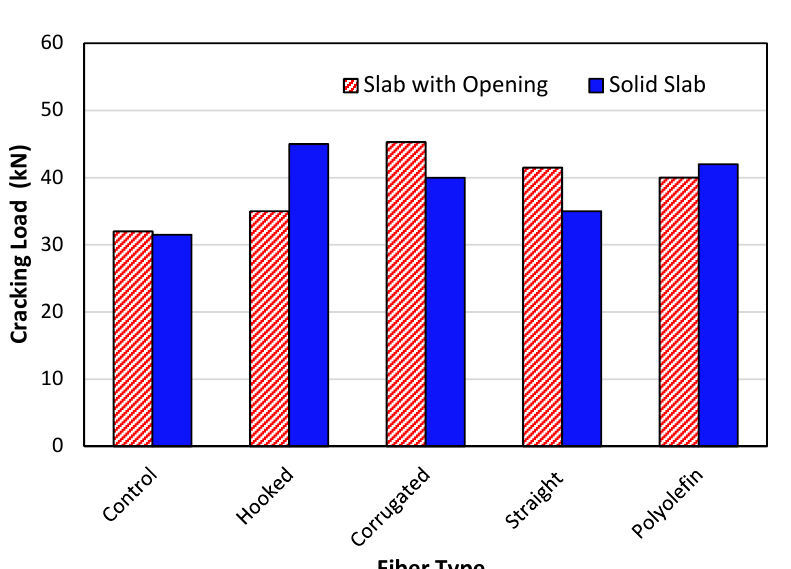
Figure 7. Cracks and failure pattern for solid slab with polyolefin.